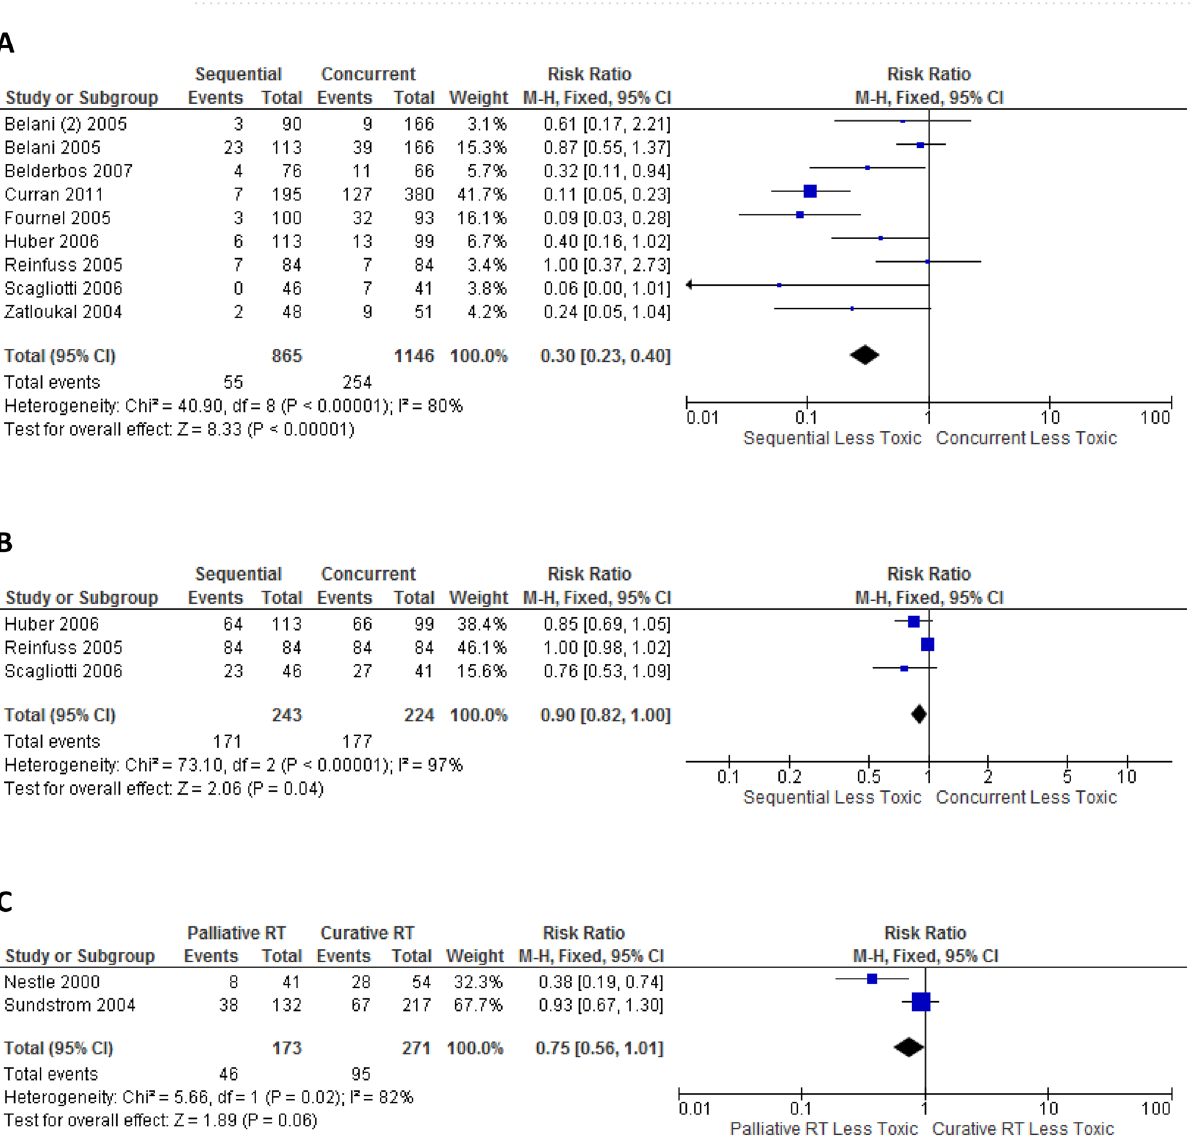
Figure 3. Forest plot showing toxicity risk ratio (RR) for: ( A ) grade ≥ 3 oesophagitis, comparison between sequential versus concurrent chemoradiation; ( B ) any grade oesophagitis, comparison between sequential versus concurrent chemoradiation; ( C ) any grade oesophagitis, comparison between palliative versus curative radiation therapy, generated with Cochrane Review Manager version